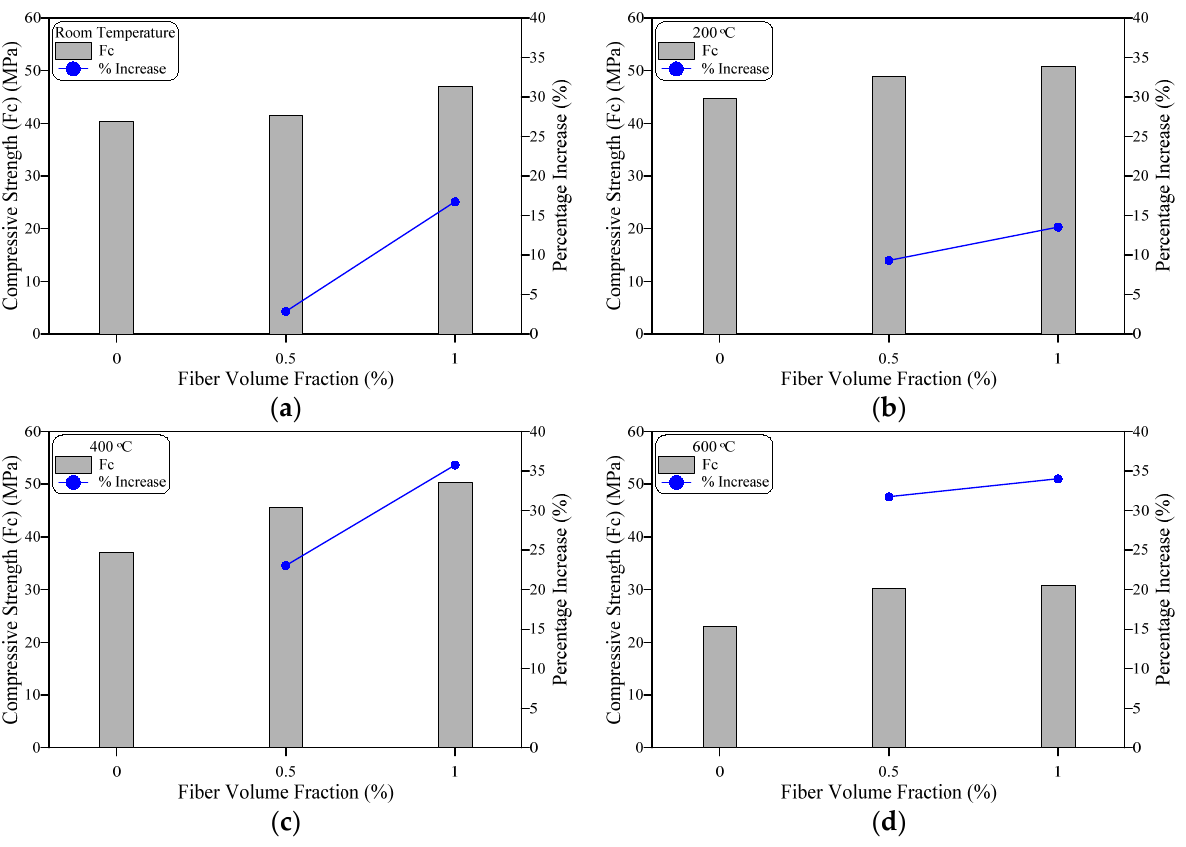
Figure 8. Compressive strength results. ( a ) Room temperature; ( b ) 200 °C; ( c ) 400 °C; ( d ) 600 °C.